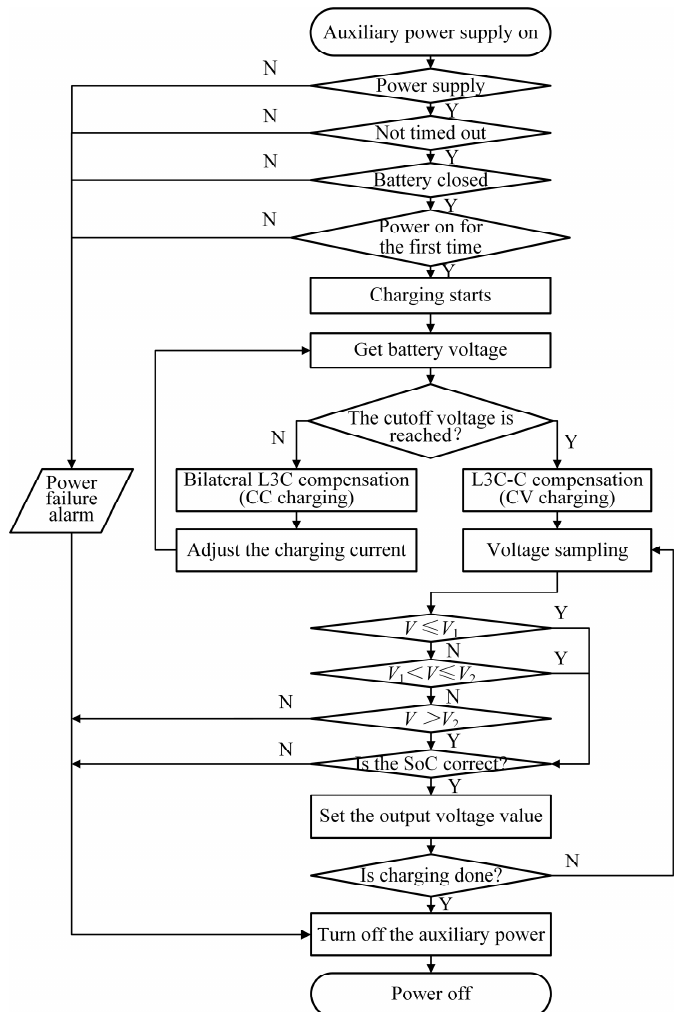
Figure 6. Charging control flow chart.